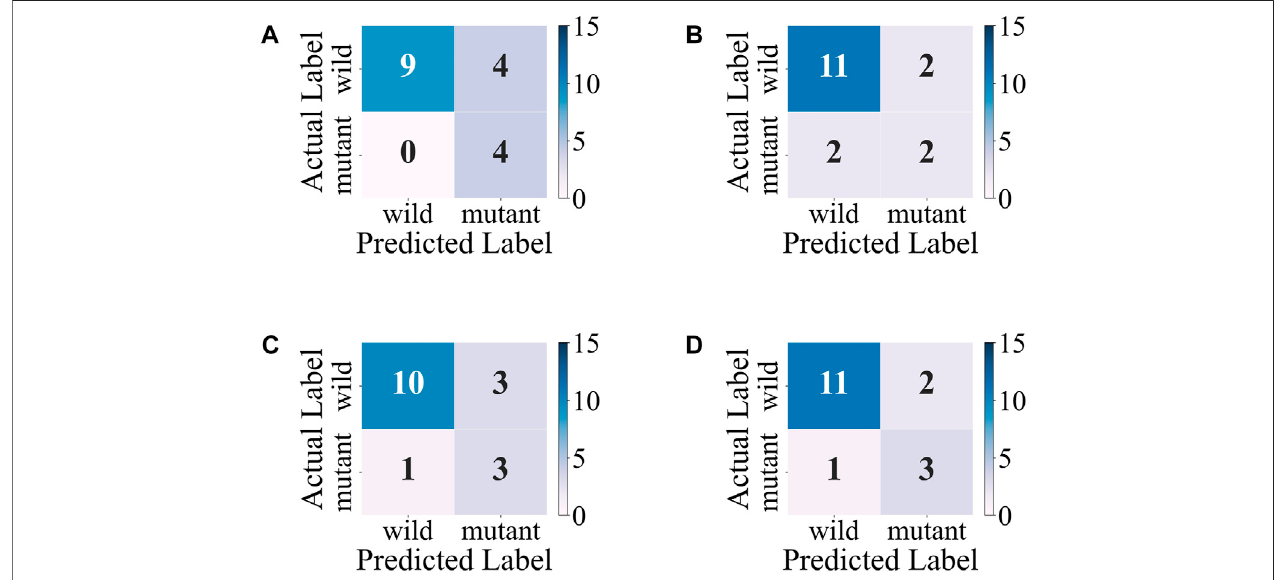
FIGURE7| Confusionmatrixesoftheensemblemodelandindividualmodelsonthetestset. (A) XGBoost. (B) SVM. (C) LR. (D) Ensemblemodelwithsoft-votingof XGBoost, SVM, and LR.